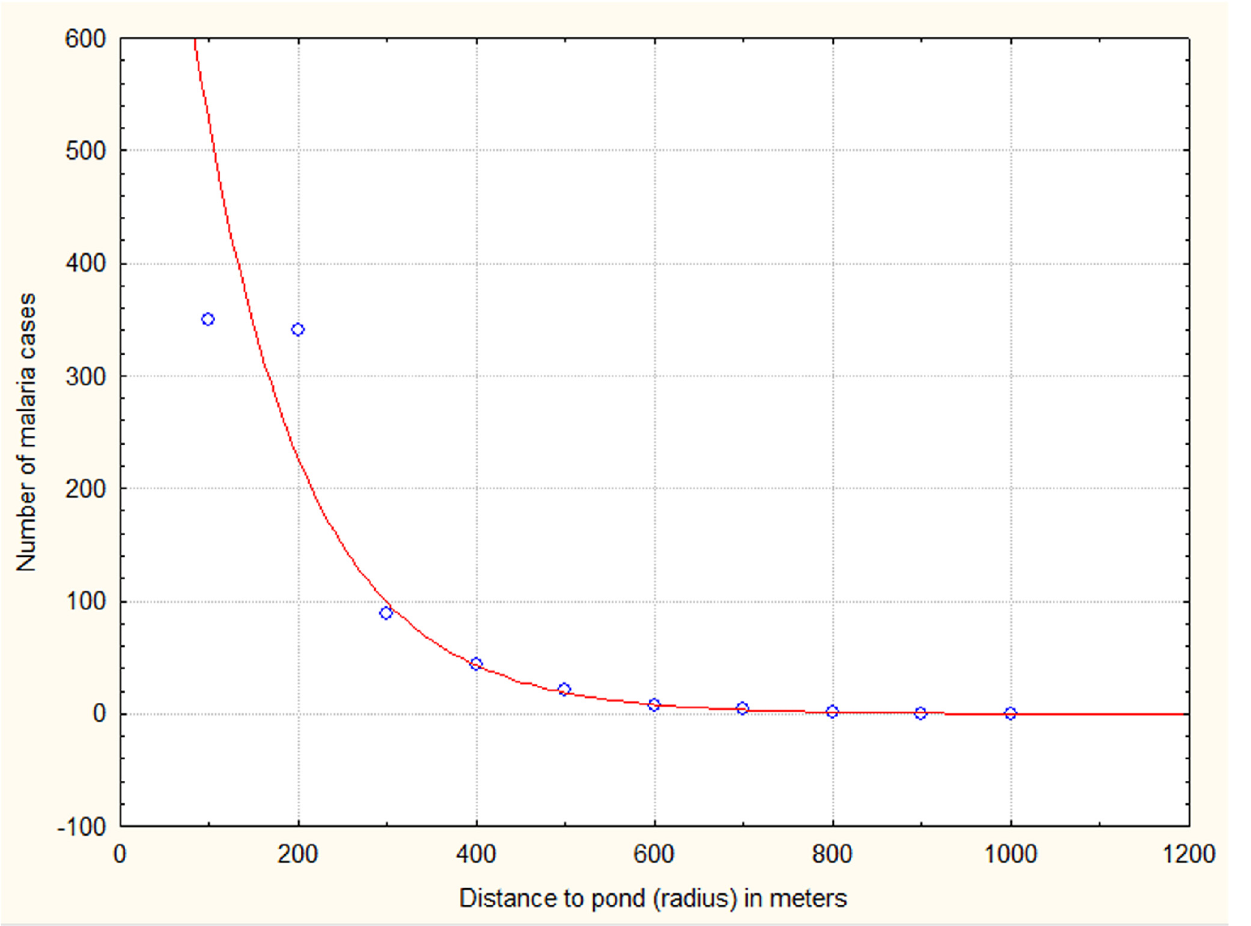
Fig 7. Scatterplot of the number of malaria cases in 2011 and 2012 as related to the distance to the nearest fish ponds, in